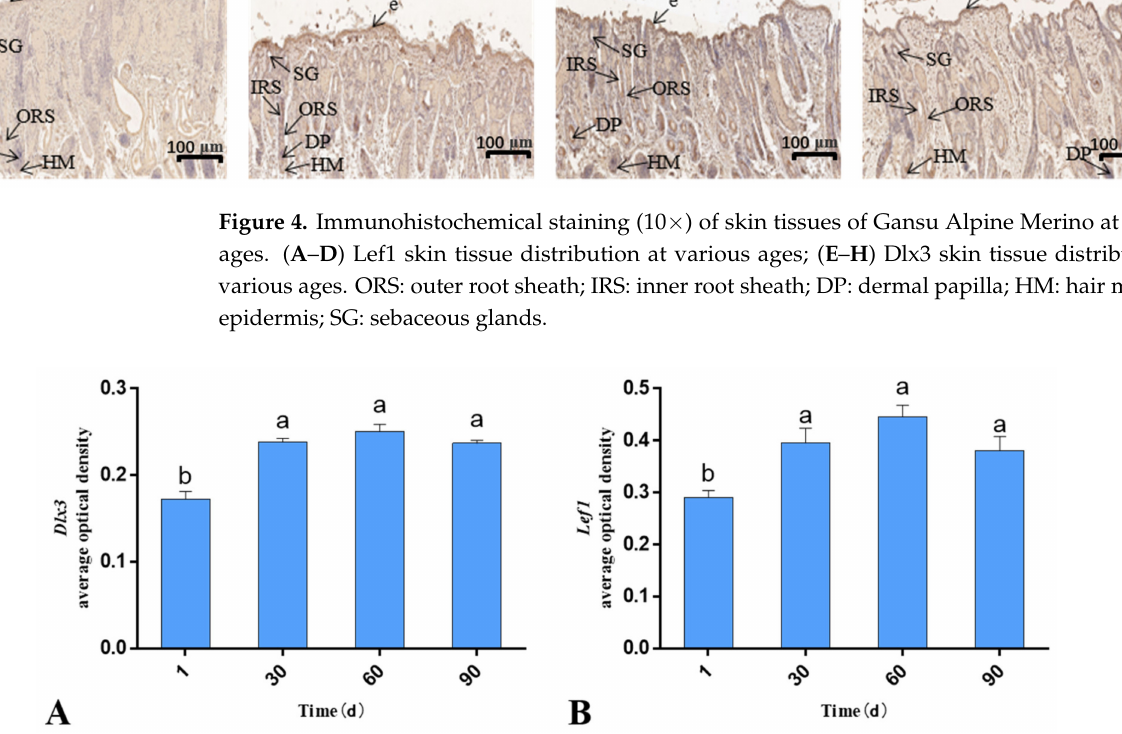
Figure 5. Statistics of the average optical density of the skin tissue of Gansu Alpine Merino at various ages as per immunohistochemical analysis. ( A ) Average optical density of Dlx3 at various ages; ( B ) average optical density of Lef1 at various ages. The data are expressed as the mean ± S.E. Different letters indicate significant differences between different ages ( p <